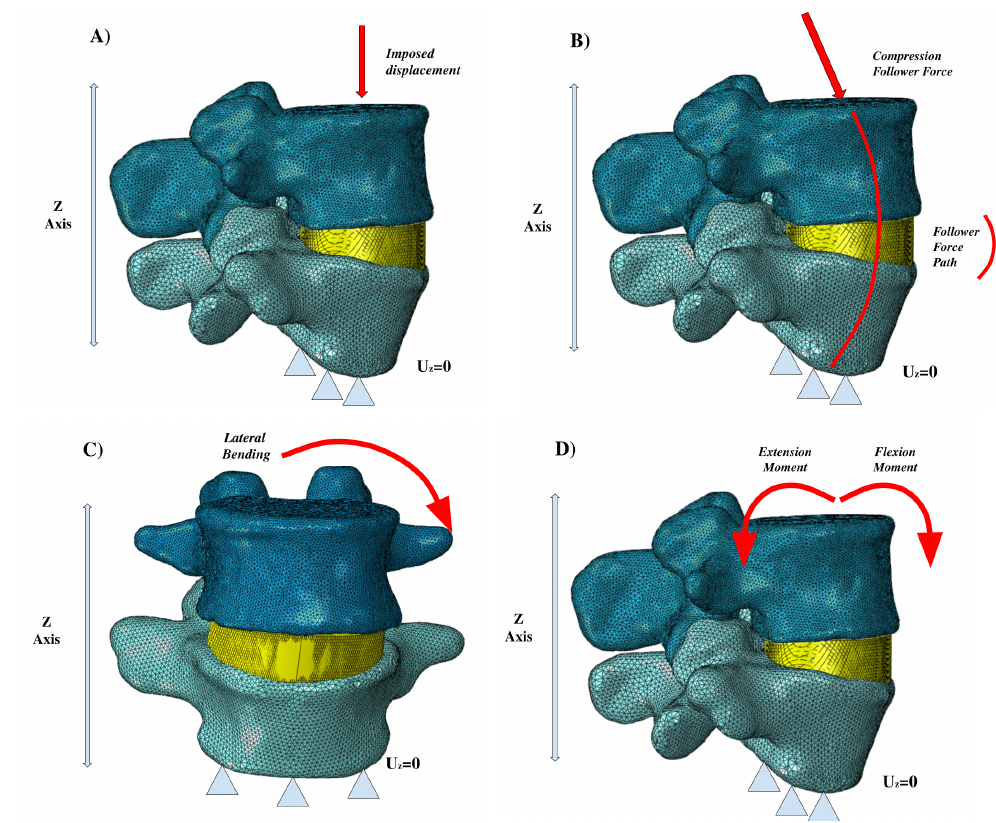
Figure 4. Different loading conditions: ( A ) imposed displacement, ( B ) compression follower force, ( C ) lateral bending, ( D ) extension and flexion